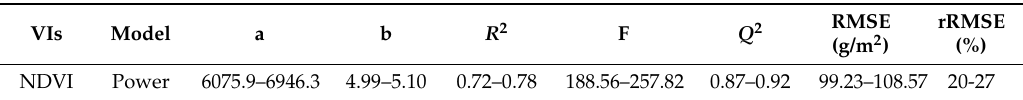
Table 7. Results from multiple random modeling for estimation of the oilseed rape AGB. The ranges for the regression parameters from several times repeating test are given; a and b represent the coefficients of the power models (AGB = a*NDVI b )